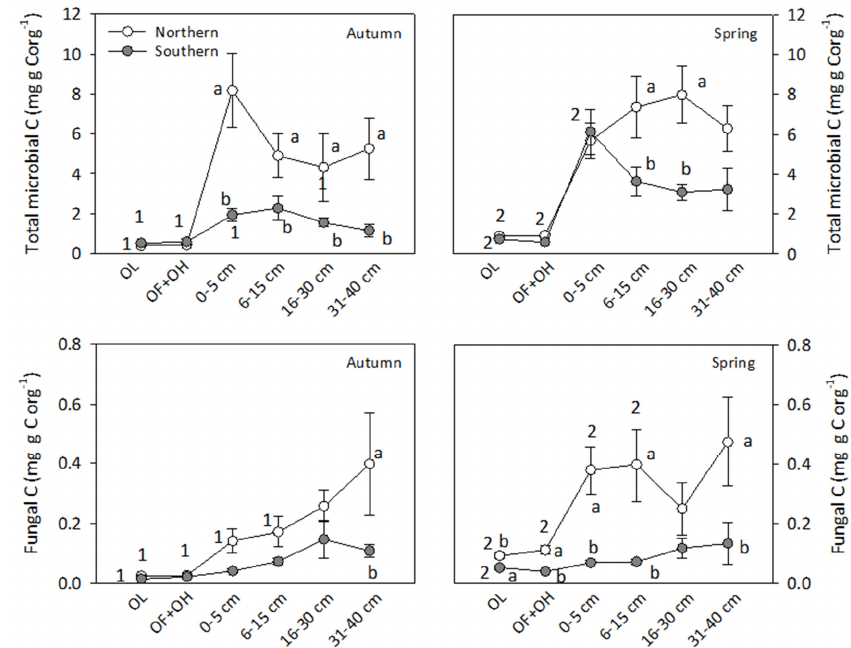
Figure 6. Total microbial and fungal biomass as C fractions % of total organic matter in the continuum forest floor ‐ mineral soil in a northern and a southern beech forest. Values are means ± standard error; n = 18 (6 sampling plots, 3 replicate analyses). Different lower ‐ case letters indicate significant differences between sites; differences between seasons are indicated by different numbers (two ‐ way ANOVA followed by post ‐ hoc Holm ‐ Šídák method; overall significance level = 0.05).